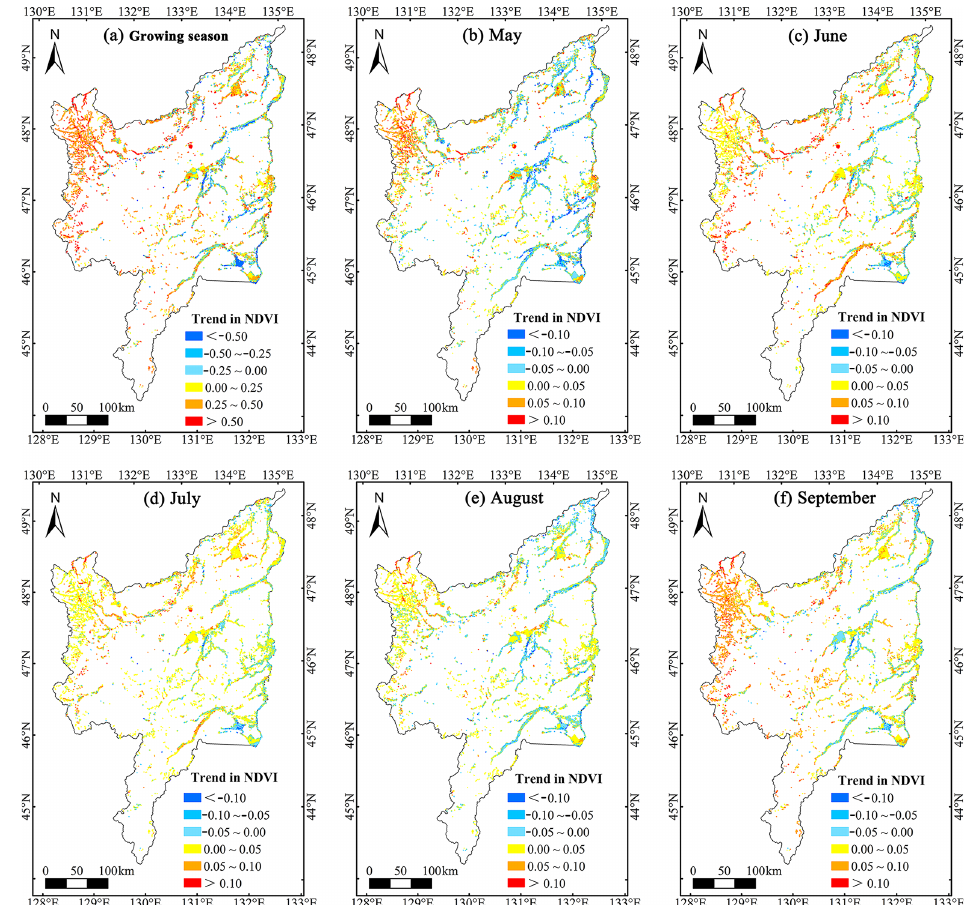
Figure 3. Change trends in vegetation NDVI (/decade) of marshes in the study region from 2000 to 2020. Table 1. Correlation coefficients between growing season (monthly) NDVI of marsh vegetation and growing season (monthly) T mean , T min , T max and precipitation during the growing season in Sanjiang Plain from 2000 to